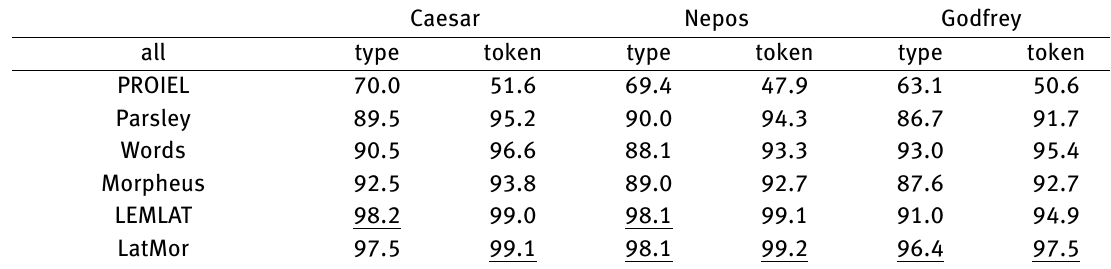
Table 1: Coverage of different morphological analyzers on three Latin texts. A wordform counts as analyzed if either the word- form itself or its lowercased form receives an analysis. The best results are